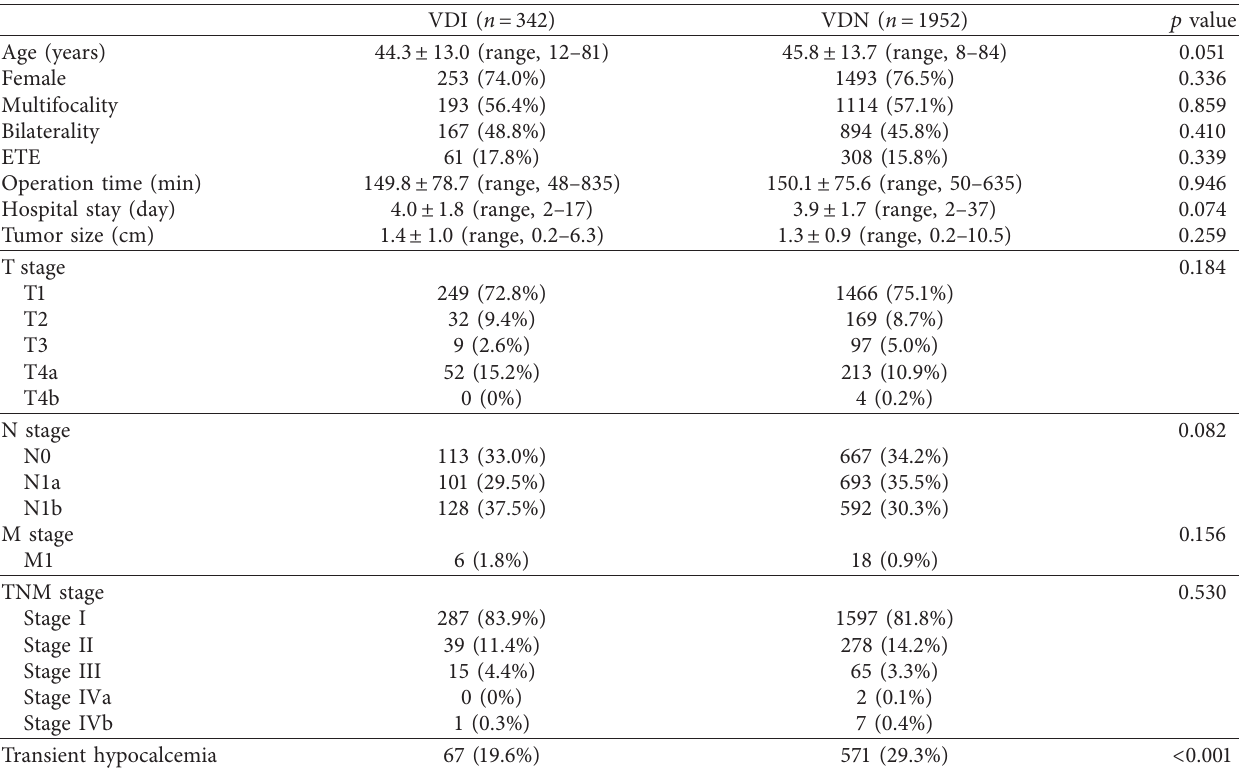
Table 1: Comparison of baseline clinicopathologic characteristics between vitamin D3 injection (VDI) and vitamin D3 noninjection (VDN)